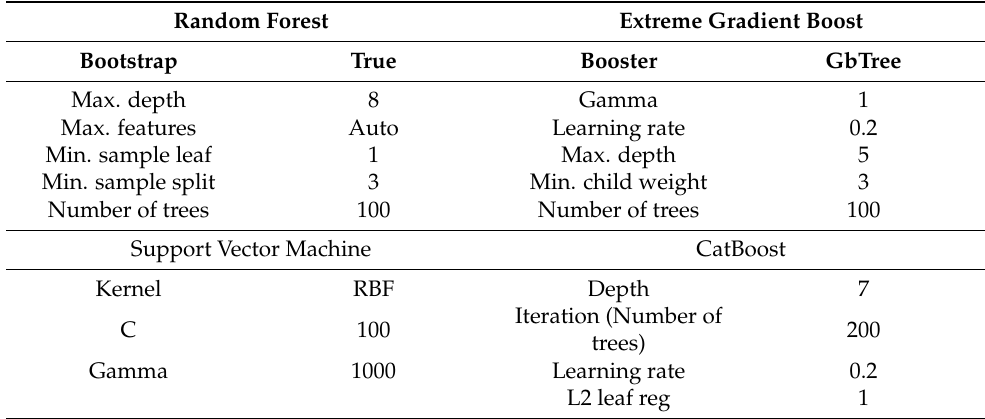
Table A2. The tuned hyperparameters of the RF, the SVM, the XGB, and the CB models. Random Forest